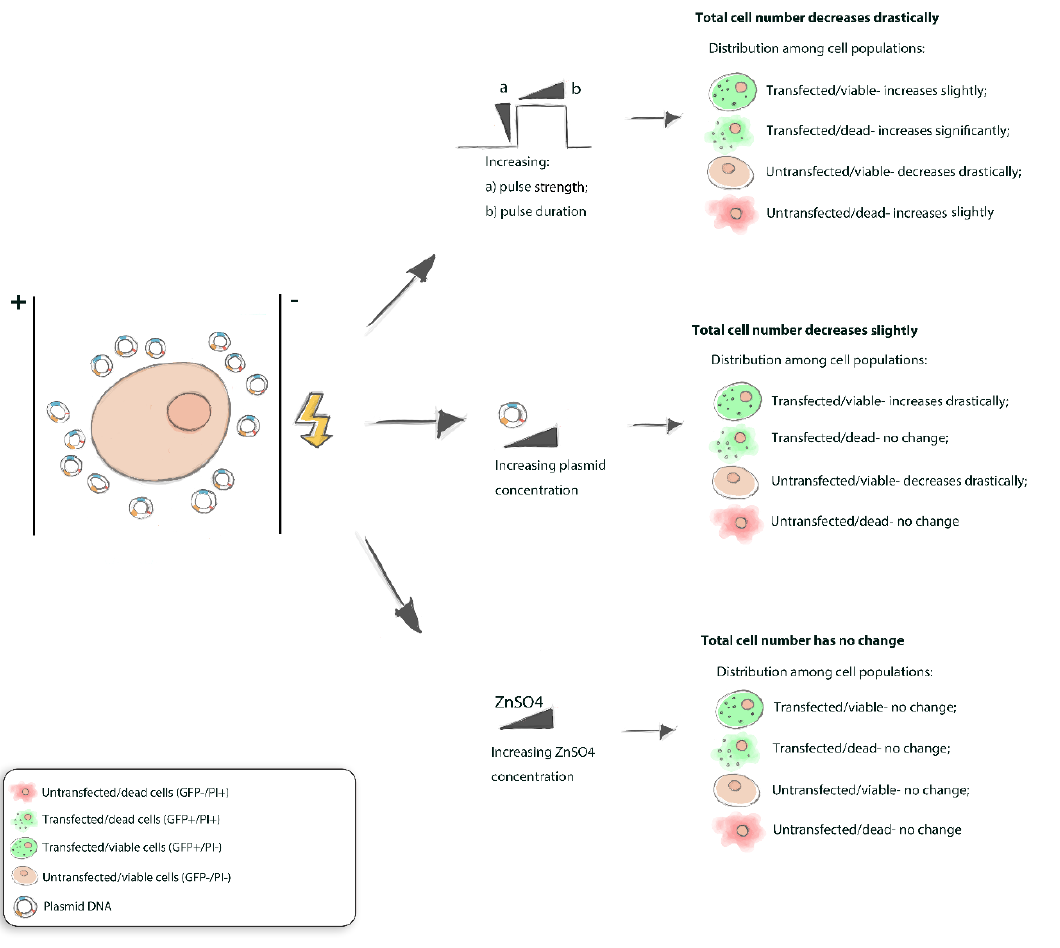
Figure 6. Overall schematic representation underlying the influence of experimental conditions af- fecting GET efficiency into suspension UT-7 cell line based on the results described. In the figure ( a ) stands for pulse strength, while ( b ) represents pulse duration.